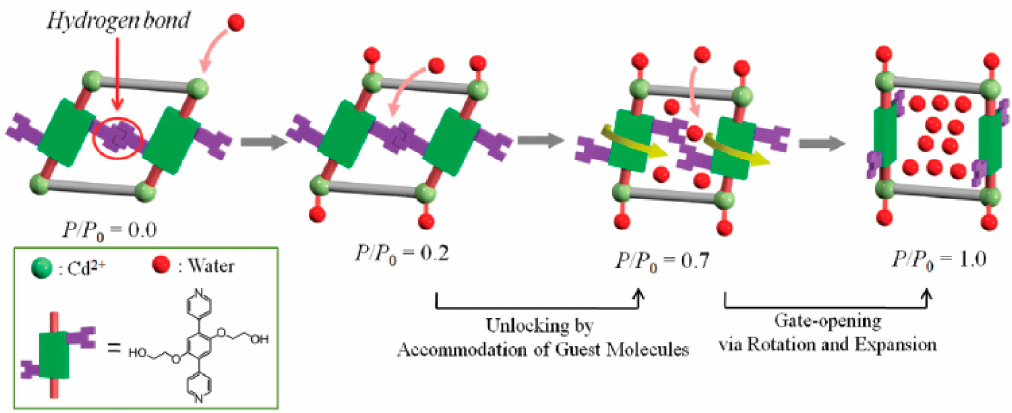
Figure 1. Schematic representation of the structural transformations triggered by water adsorption